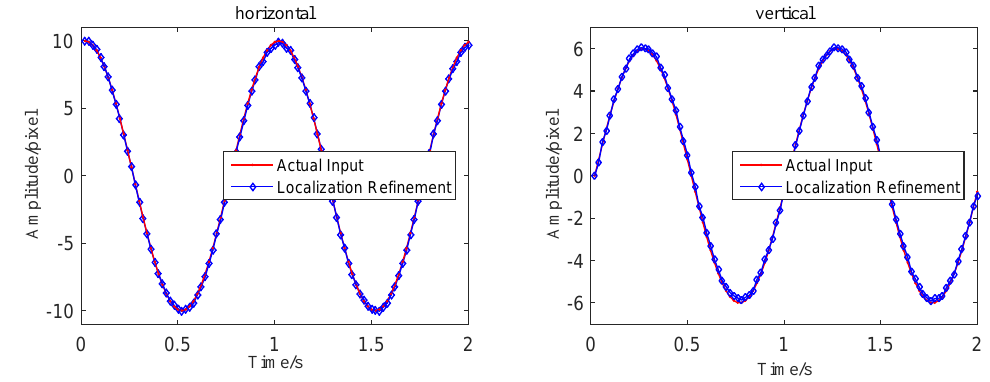
Figure 8. Comparisons of displacement extraction results between the actual input and the MCC with subpixel localization